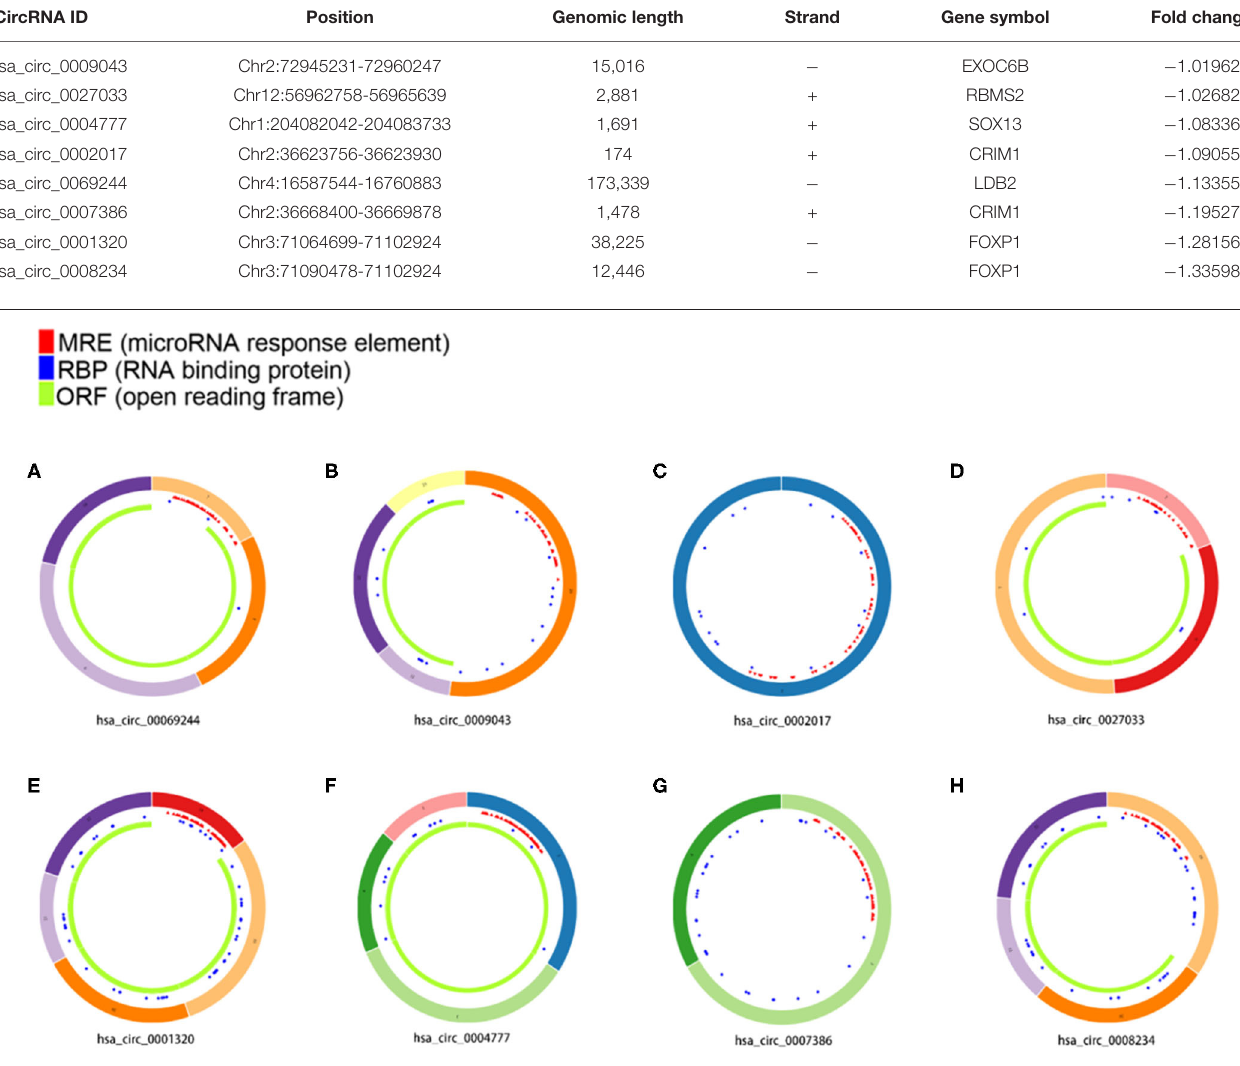
FIGURE 4 | Structural patterns of the eight circRNAs: (A) hsa_circ_00069244, (B) hsa_circ_0009043, (C) _circ_0002017, (D) hsa_circ_0027033, (E) hsa_circ_0001320, (F) hsa_circ_0004777, (G) hsa_circ_0007386, (H) hsa_circ_0008234. pathway,” “Thyroid hormone signaling pathway,” and “Prostate cancer” ( Figure 6